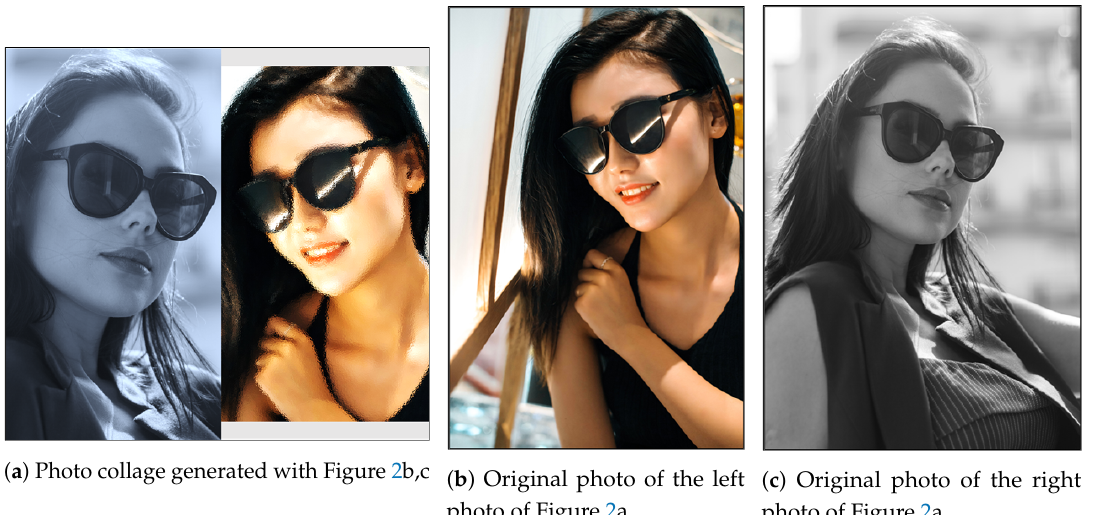
Figure 2. Example of a photo collage with two cropped photos. In these photos, the sunglasses are the target object for unauthorized use. The source of these photos is https://unsplash.com (accessed on 27 September 2021), which provides copyright-free